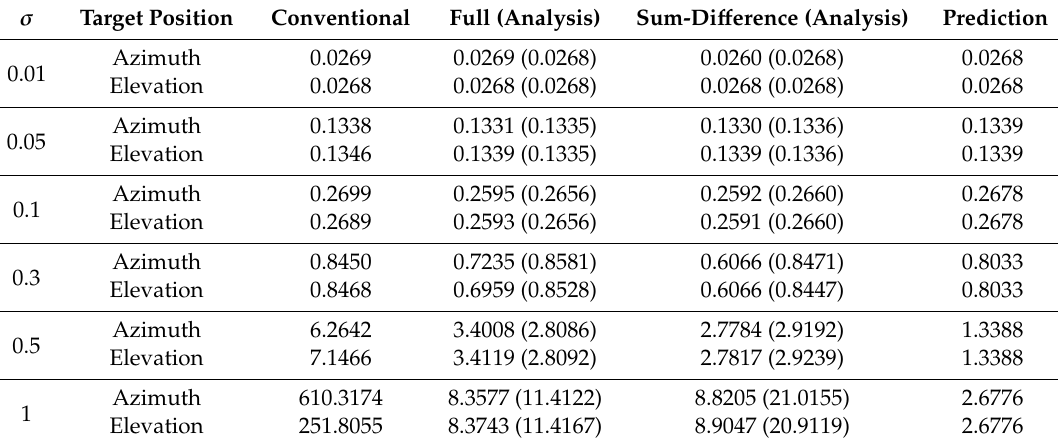
Table 1. RMS errors for noise levels: θ 3 dB = 3 ◦ , θ s = 1 ◦ , θ az = 0 ◦ , θ el = 0 ◦ .